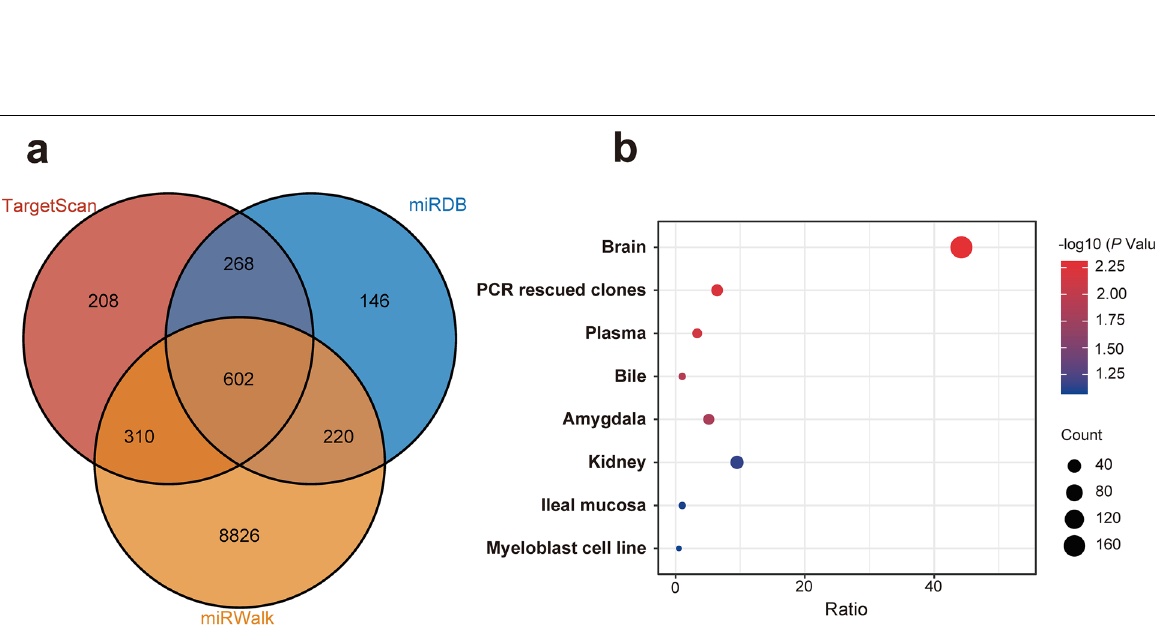
Fig. 3 Predicted target genes of hsa-miR-9-5p. a A total of 602 target genes of hsa-miR-9-5p were predicted by all of the Targetscan, miRDB, and miRwalk softwares. b Tissue enrichment analysis suggested that the target genes were most highly expressed in the brain, especially in the